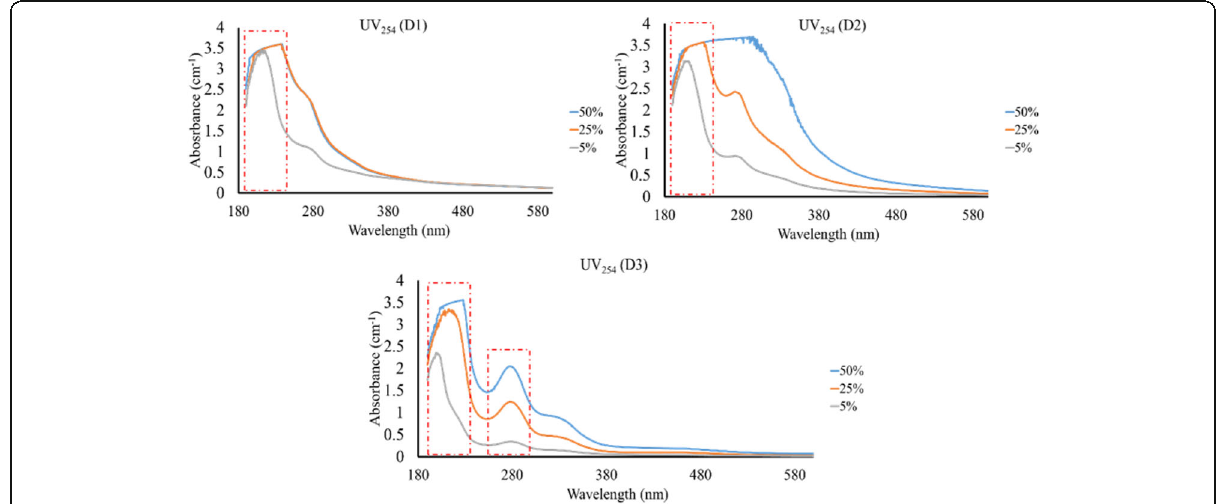
Fig. 2 UV 254 curves used to identify HA and FA at 50, 25, and 5% doses for each digestate